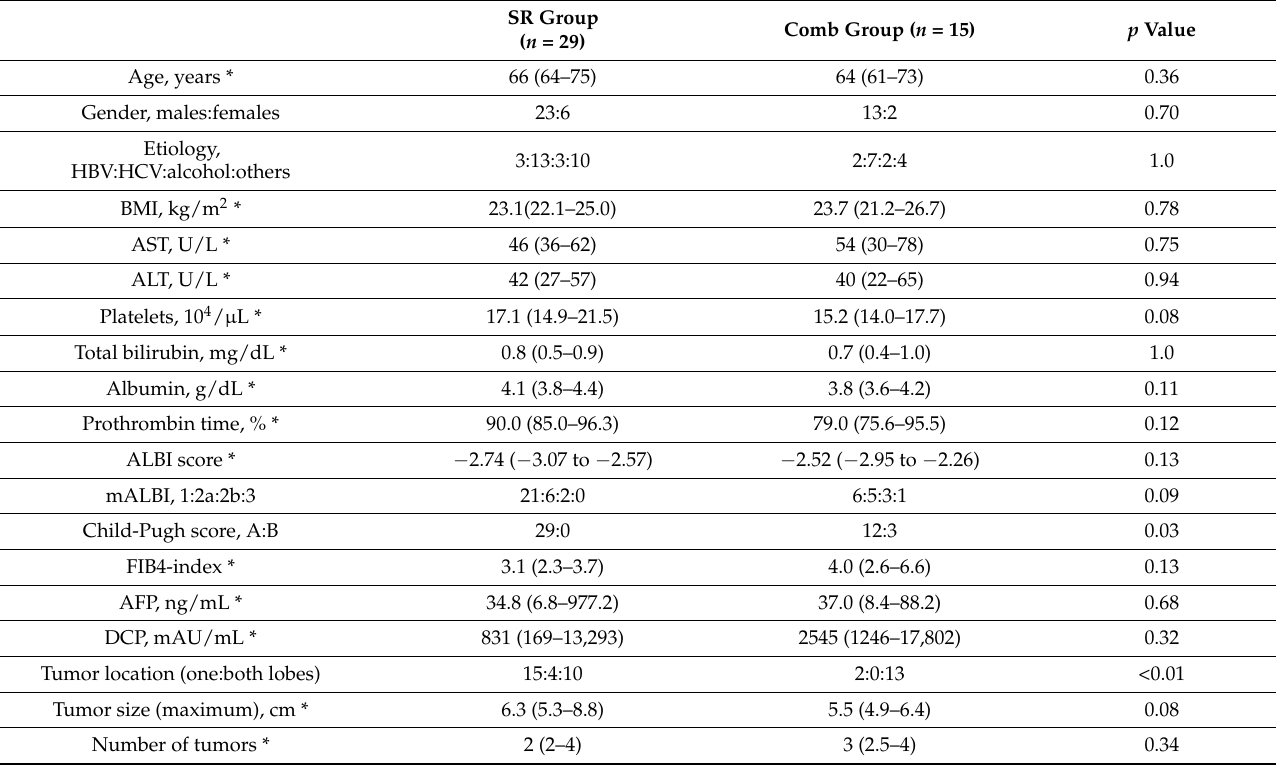
Table 2. Characteristics of patients classified as beyond up-to-7 criteria ( n = 44).